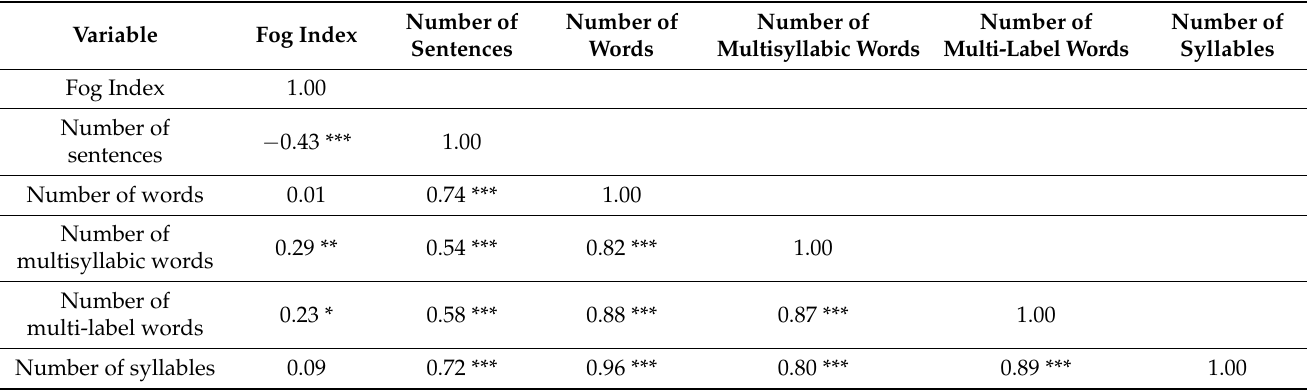
Table 4. Correlation analysis between detailed parameters of the text.